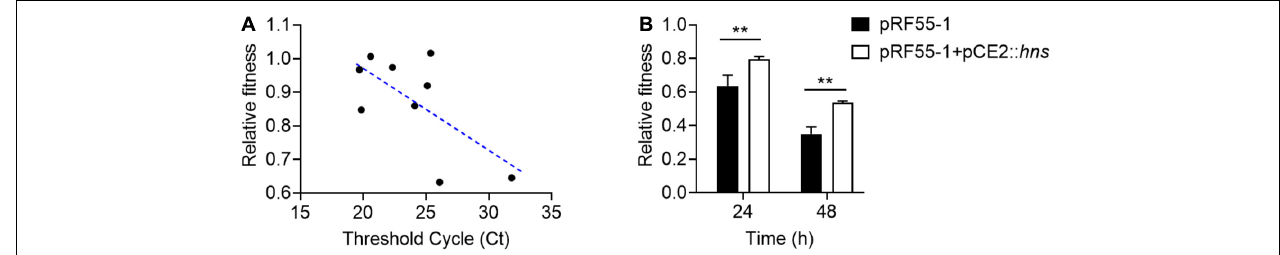
FIGURE 4 | H-NS has a critical role in the fitness of tet (X4)-positive IncX1 plasmids. (A) Negative correlation between relative fitness and hns Ct value by quantitative real-time PCR. (B) The presence of H-NS protein improves the relative fitness of E. coli TOP10 carrying plasmid pRF55-1. Plasmid pRF55-1 is tet (X4)-bearing IncX1 plasmid without hns gene. Data are representative of three biological replicates and shown as mean ± SD. p -values were determined by unpaired t- test (** p < 0.01).